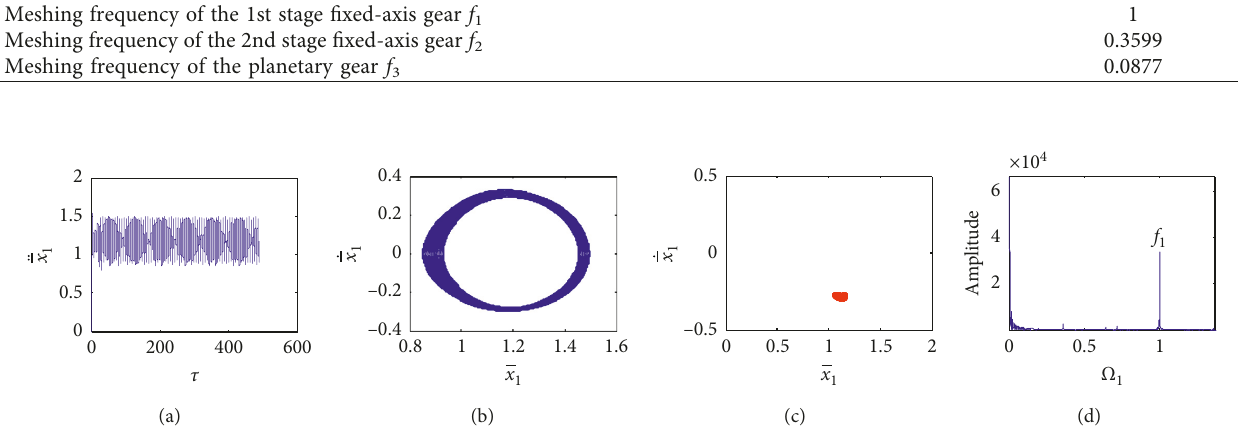
� 0.5: (a) time domain, (b) phase diagram, (c) Poincar´e section, and (d) frequency domain. 1